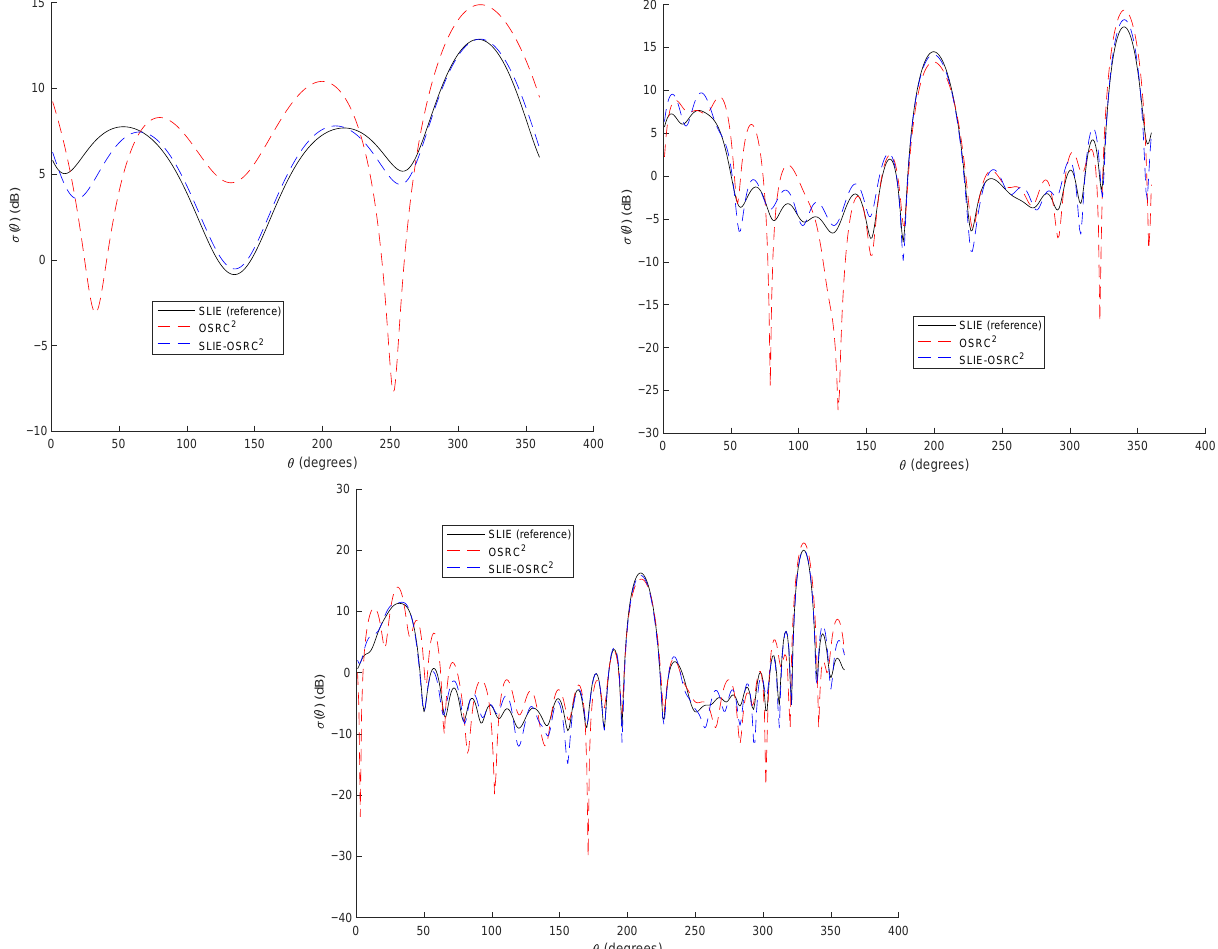
Figure 2. Bistatic SCS for the unit square cylinder with cavity and Dirichlet boundary condition: Case 1: k = 2 and θ inc = 135 deg., Case 2: k = 8 and θ inc = 160 deg. and Case 3: k = 14 and θ inc = 150